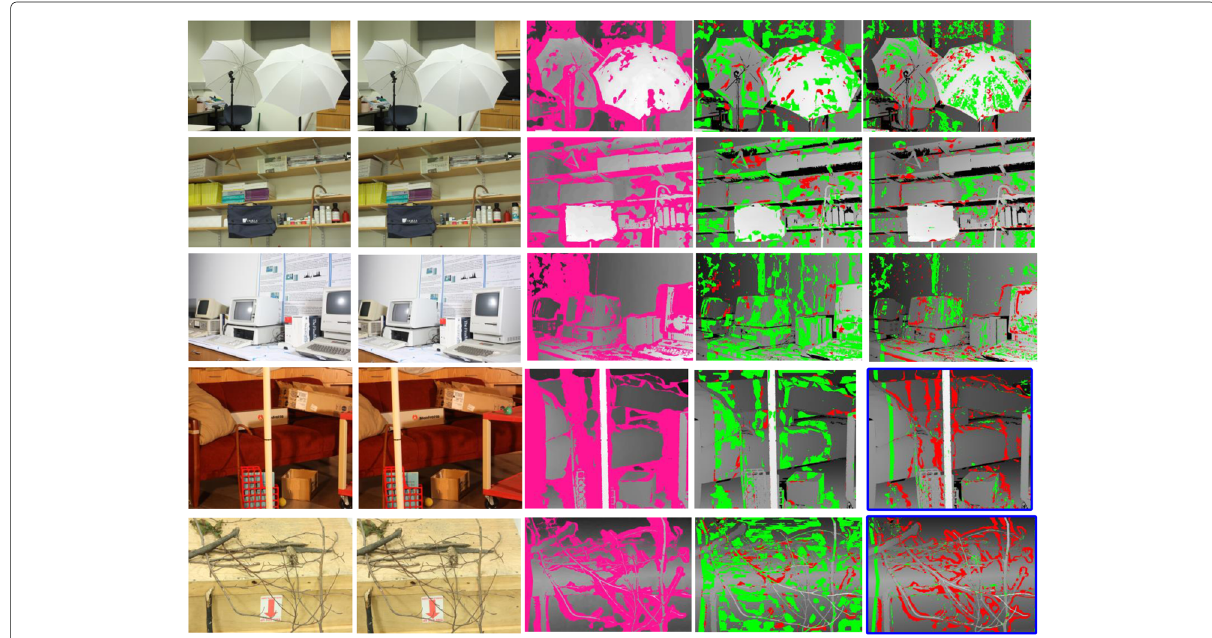
Fig. 11 Representative examples of disparity estimation from the 2014 Middlebury Stereo Dataset. Columns 1 and 2: the stereo pairs. Column 3: disparity estimation results by the proposed method, where pink denote pixels with incorrect disparity estimations. Column 4: comparison of the proposed method with Min et al.’s method [14]. If the disparity of a pixel is correctly estimated by the proposed method but incorrectly by Min et al.’s method, the pixel is shown in green color; otherwise, it is shown in red color. Column 5: comparison of the proposed method with the census transform using the same color convention. A blue border around the image indicates the case where the proposed method performs worse compared to the other